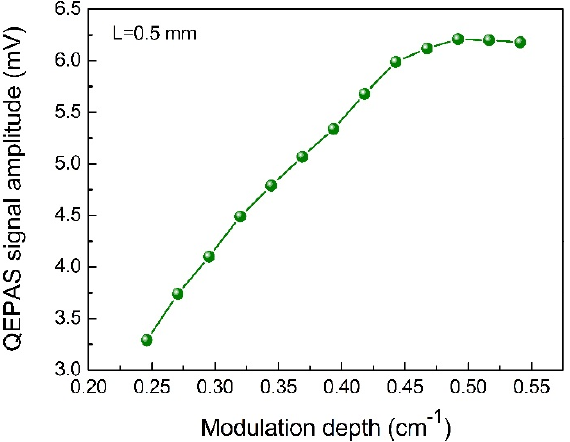
Figure 8. Experimental measured H 2 O ‐ QEPAS signal amplitude as a function of modulation depth.